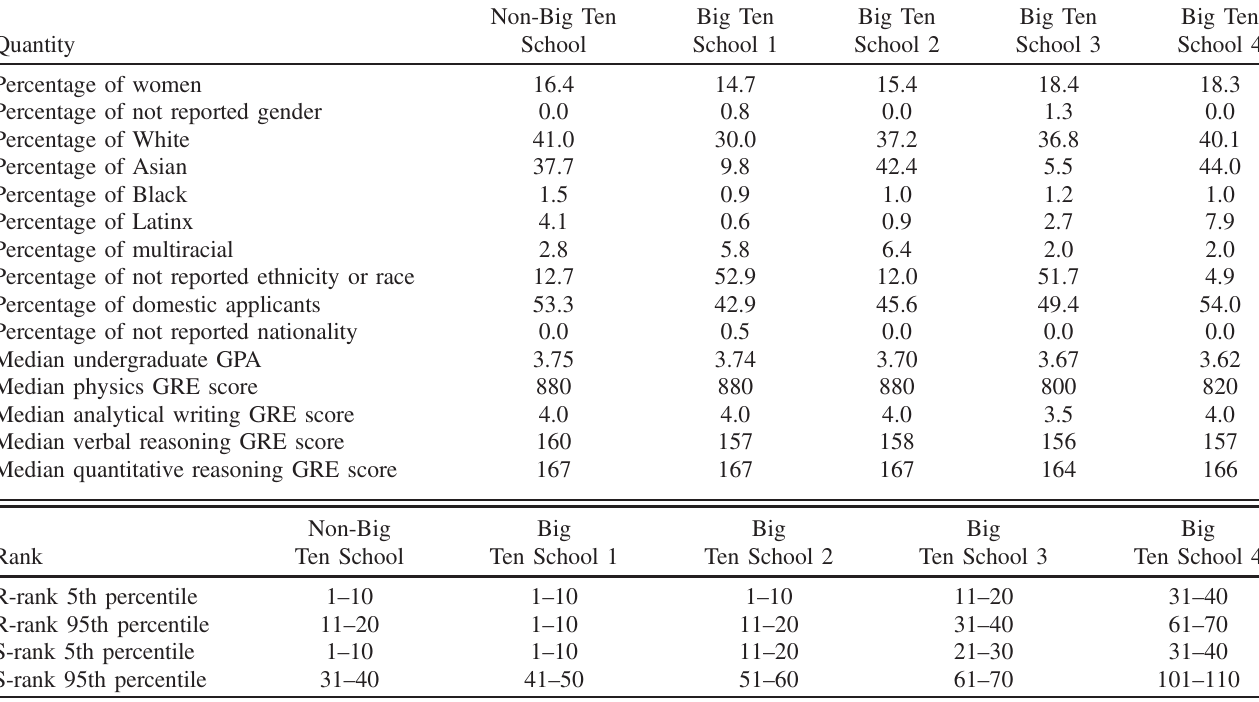
TABLE I. A comparison between the four public Big Ten universities and the private Non-Big Ten Midwestern university based on the admissions records [Table (a)] and the National Research Council ’ s R-rank and S-rank ratings [Table (b)]. (a) A comparison of the admissions records. The Non-Big Ten records share several similarities with the records from the other universities, especially in terms of women ’ s representation, share of domestic applicants, and academic performance. Additionally, the discrepancy seen in the distribution of racial and ethnic applicants can be explained by the applicants who did not report ethnicity or race. Further details regarding the contents of the admissions records data are provided in Sec. III A. (b) A comparison of the R-rank and S-rank from the National Research Council [23]. For the sake of anonymity, only ranges of ranks are presented. The Non-Big Ten school certainly does not stand out as a contrast to the Big Ten schools. The similarities between the profiles of the universities justify analyzing the records as a single pool of applicants.